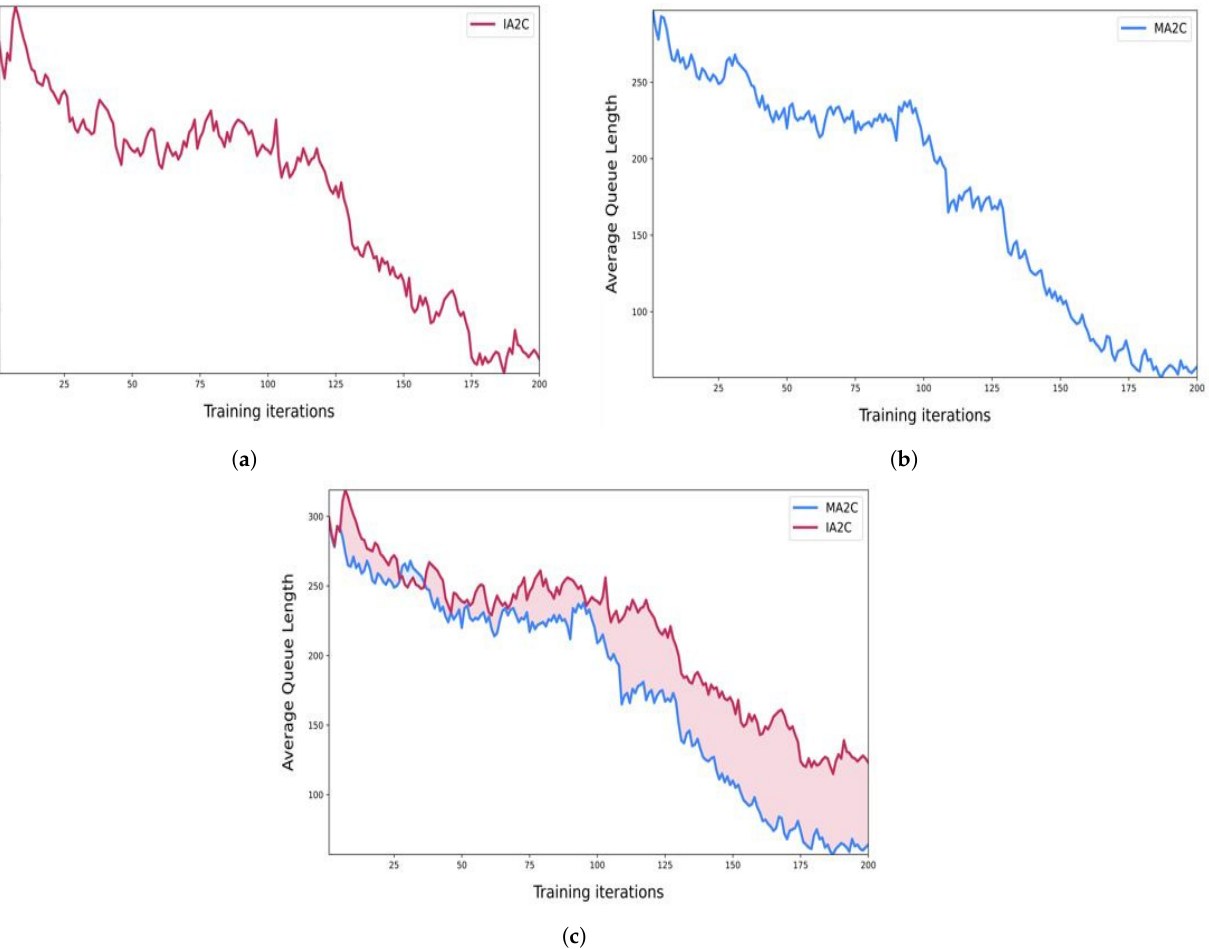
Figure 4. Average Queue Length comparisons. ( a ) Average Queue Length IA2C. ( b ) Average Queue Length MA2C. ( c ) Comparisons for Average Queue Length IA2C and